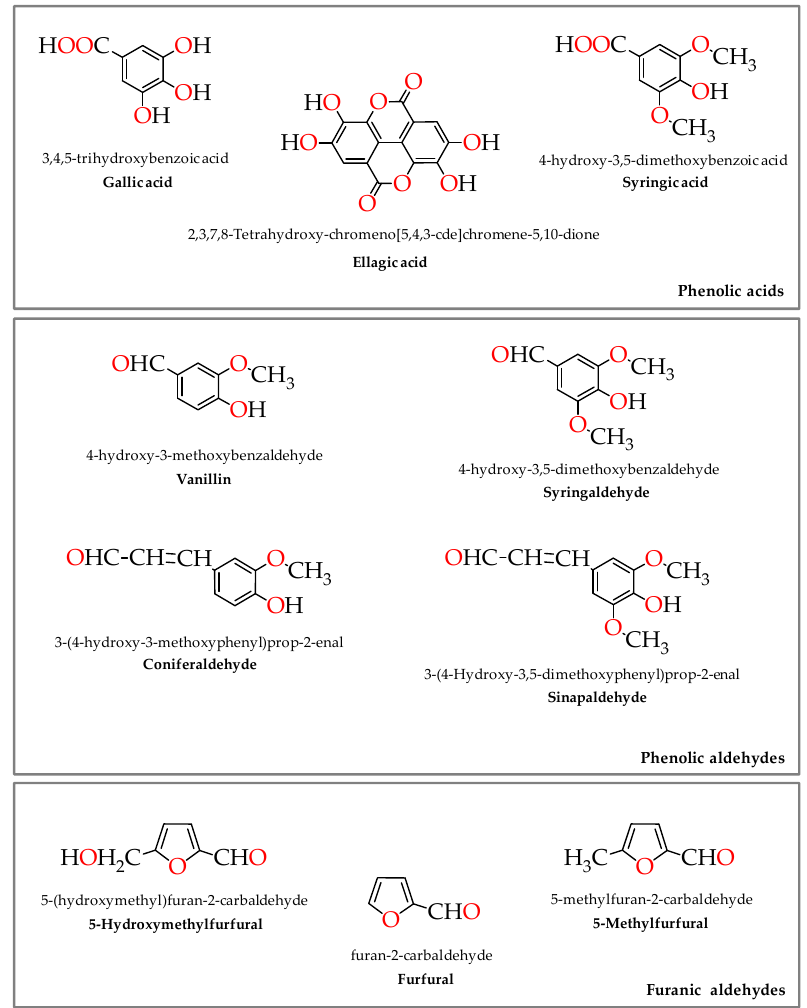
Figure 1. Chemical structure of phenolic acids, phenolic aldehydes and furanic aldehydes present in the aged